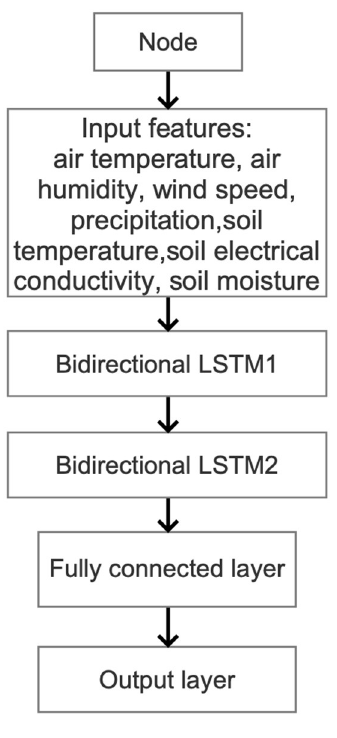
Figure 8. Bid-LSTM network diagram.